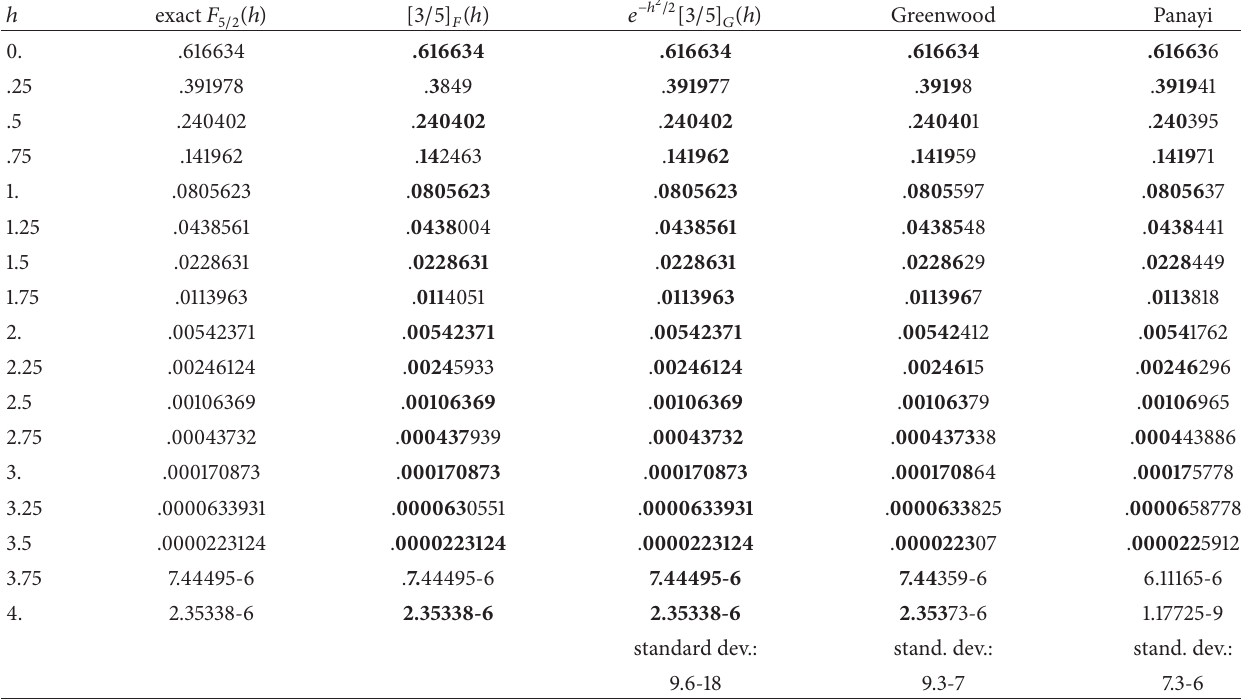
Table 4: 9-point Pad´e approximation of 𝐹 5/2 obtained directly and also via approximation of 𝐺 5/2 . Comparison with Greenwood and Panayi